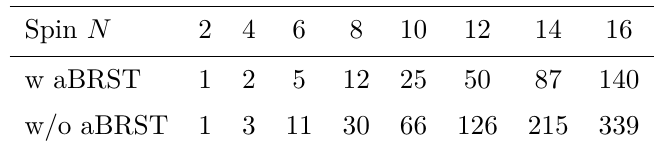
Table 3 . Table showing the number of independent operators with and without the use of anti- BRST (aBRST)